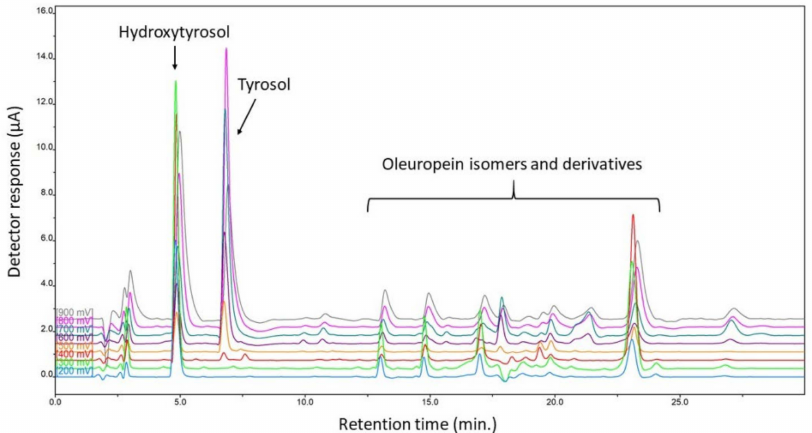
Figure 1. Chromatogram of WEOO of Ballester extra-virgin olive oil. Chromatographic conditions—